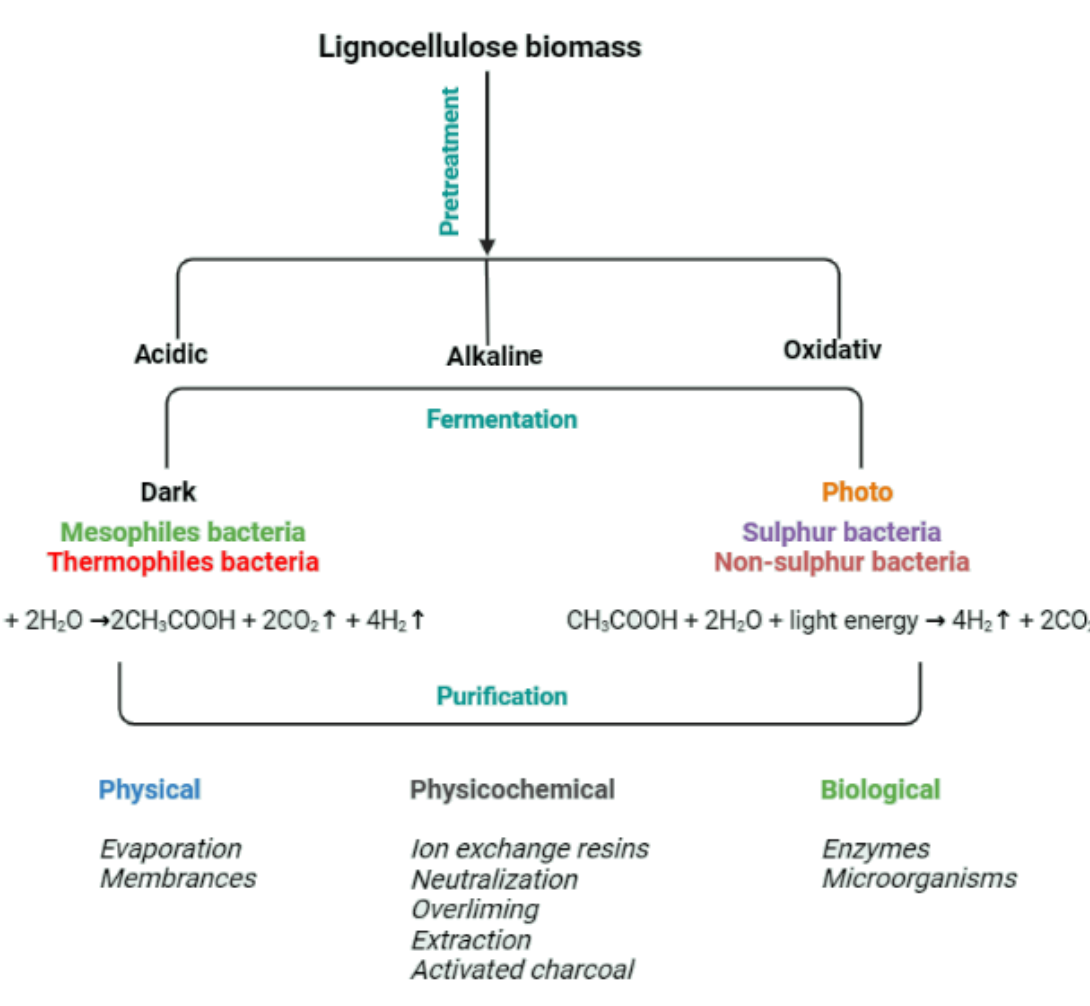
Figure 5. The procedure of biomass pre-treatment and the applied methods for broths purification